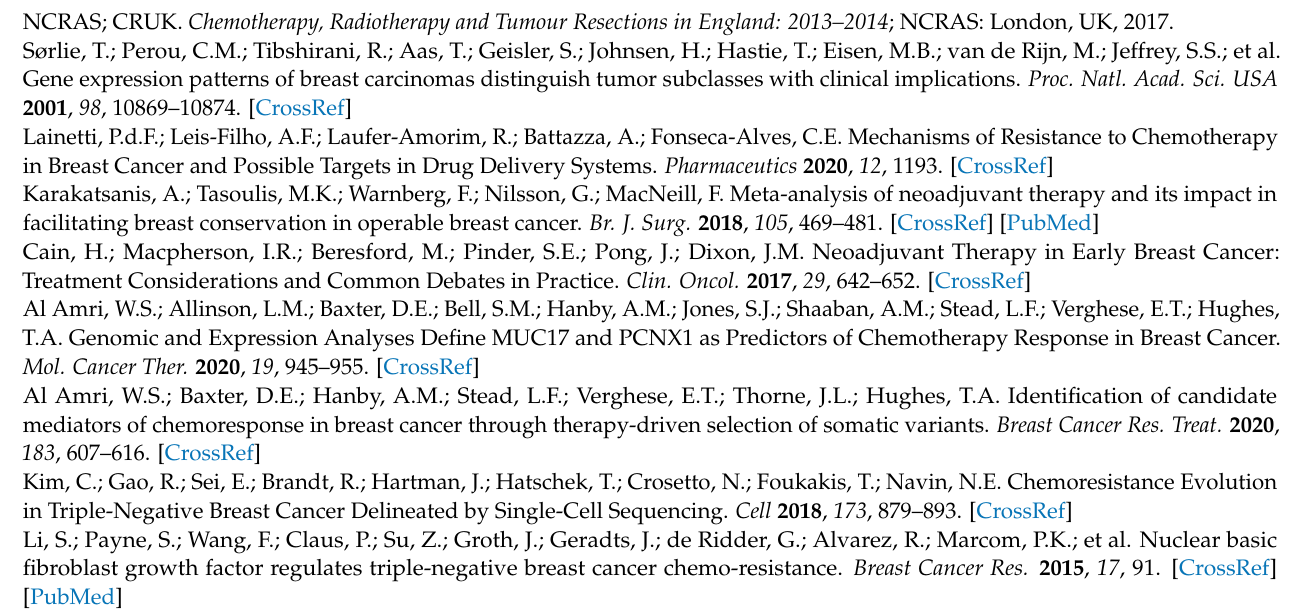
Figure S2: MiR-195 and miR-26b are overexpressed in a epirubicin-resistant cell line. Figure S3: Biotin- tagged miR-195 and miR-26b mimics induce chemoresistance in MCF7 cells. Figure S4: Predicted binding sites for miR-195 and miR-26b in the 3’ untranslated region of the SEMA6D transcript. Figure S5: SEMA6D expression was significantly reduced in epirubicin-resistant MCF7 cells as compared to parental. Figure S6: Low SEMA6D expression predicts poor survival in patients with estrogen receptor negative cancers and with HER2 positive cancers. Table S1: Clinico-pathological features of the discovery breast cancer cohort (n = 5; all estrogen receptor positive / HER2 negative). Table S2: Clinico-pathological features of the validation breast cancer cohort (n =